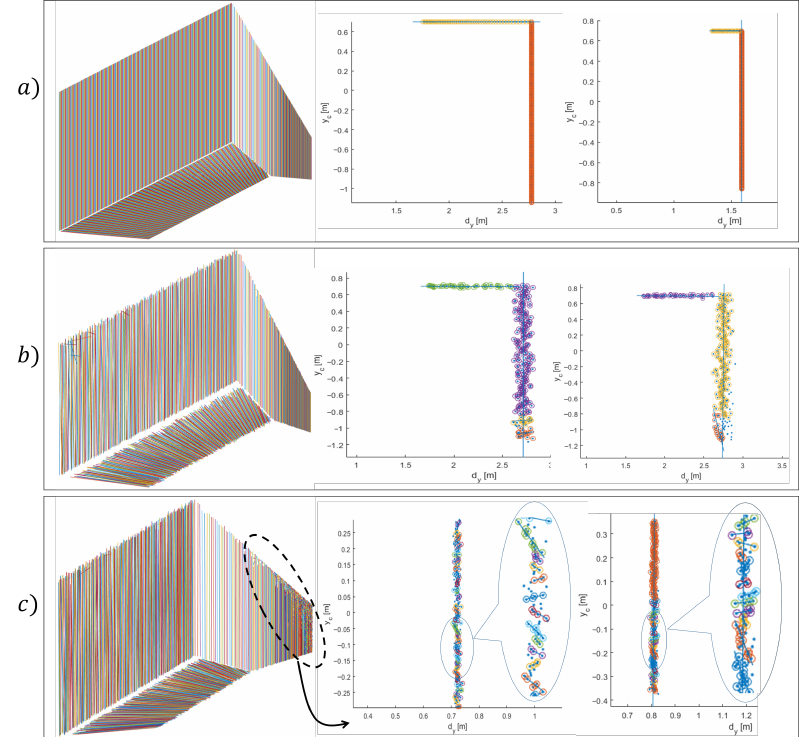
Figure 13. Line segment detection on ideal data ( a ), which also confirms the proposed methodological and structural form of data processing; ( b ) shows an example of detection on corrupted data, which produces low over-segmentation but still succeeds in detecting representative line segments with appropriately selected input parameters that are given in Table 1; ( c ) example of the high rate of over-segmentation when k min is small ( l = 2, l v =